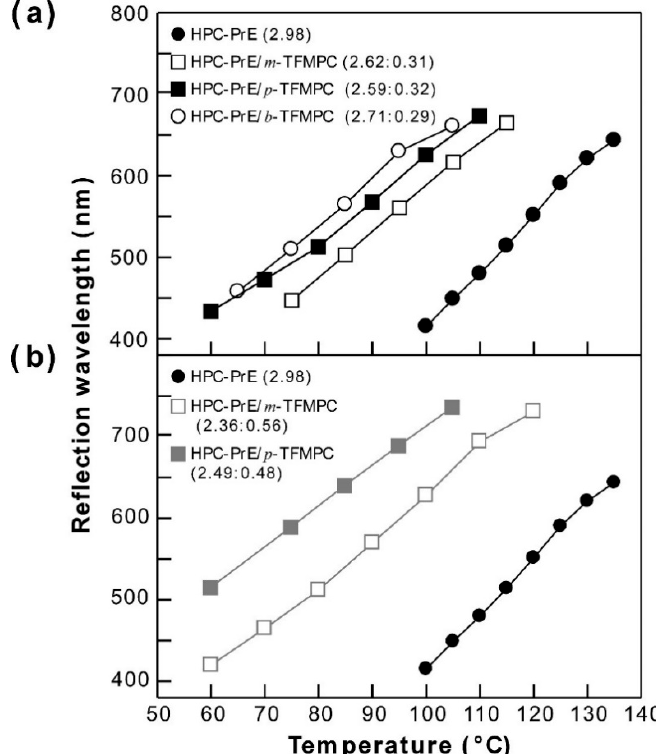
Figure 3. Temperature dependences of Bragg reflection wavelengths observed from a series of HPC derivatives with propionyl esters and (trifluoromethyl)phenyl carbamates. In the profiles of ( a ) and ( b ), the (trifluoromethyl)phenyl carbamate degrees were 0.29~0.32 and 0.48~0.56, respectively.